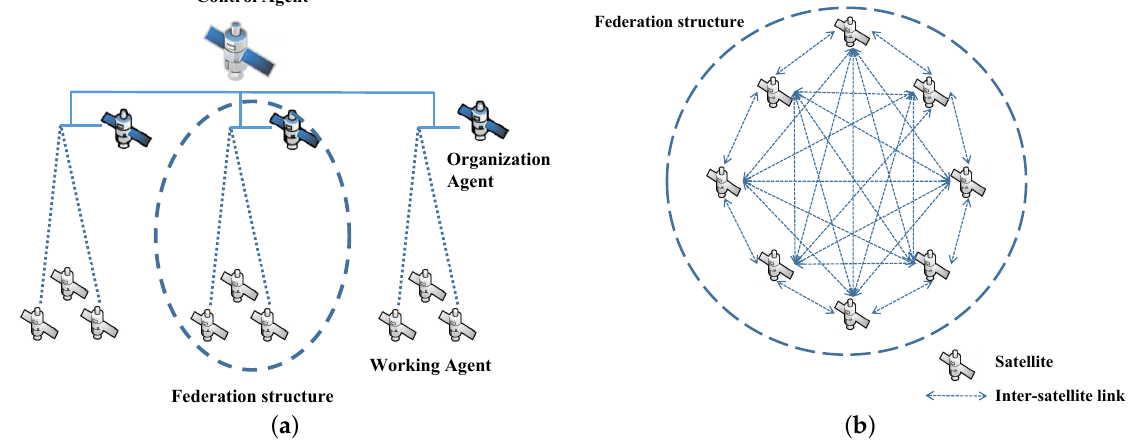
Figure 2. The central-distributed satellite cooperation federation architecture: ( a ) The multi-level management mode of the federation architecture is divided into control layer, organization layer and working layer. Each organizational agent manages a federated structure. ( b ) Agent in each federal structure exchange information in both